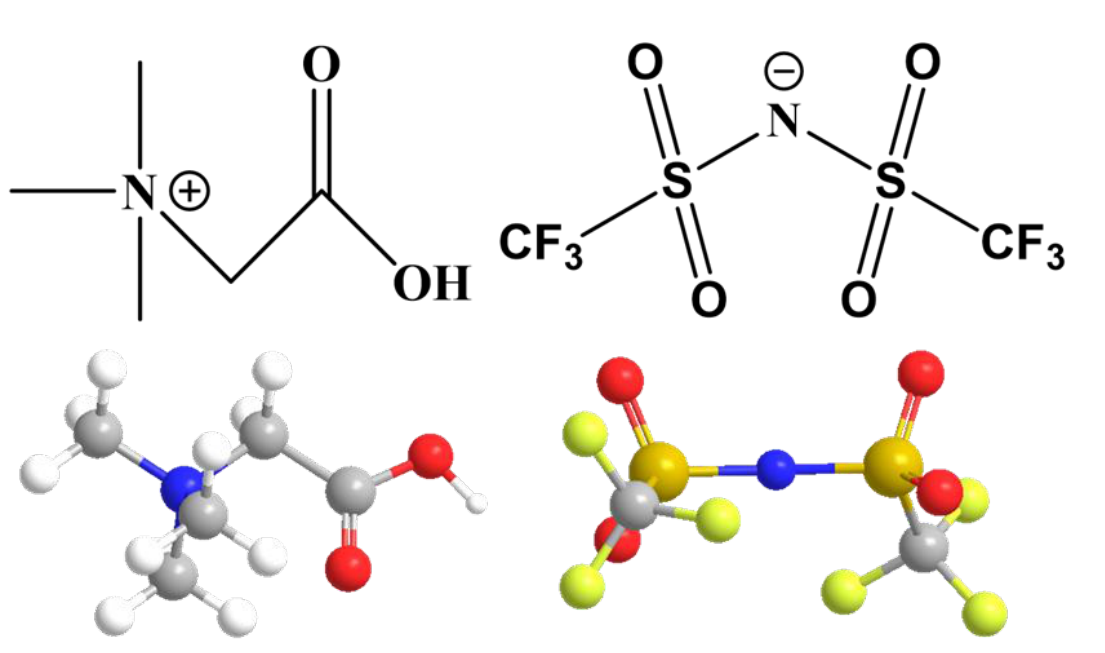
Figure 1. The structure of the ionic liquid [Hbet][Tf 2 N].